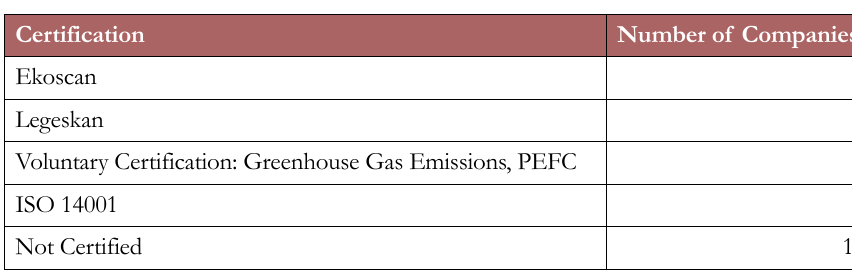
Table 1. Environmental certifications